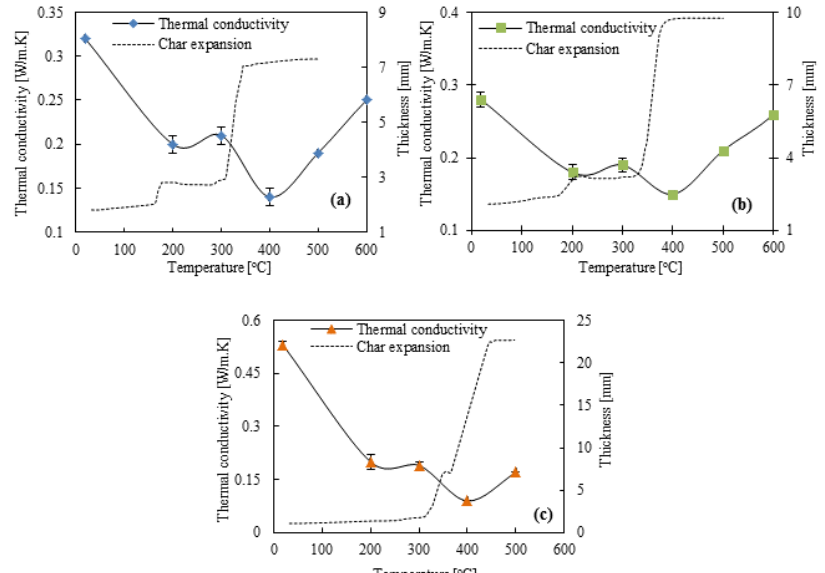
Figure 10. The relationship between char expansion and thermal conductivity values vs. temperature of ( a ) EI, ( b ) ED-I and ( c ) WI.